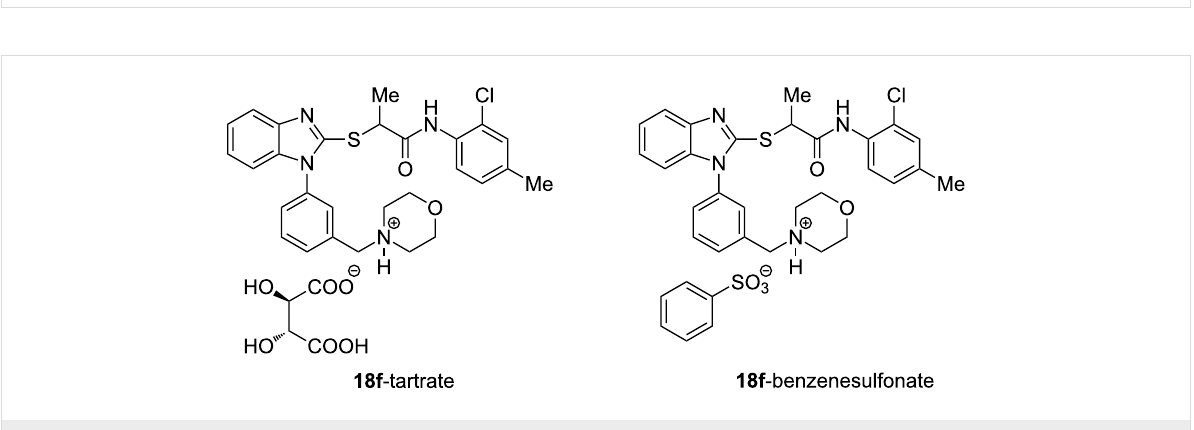
Figure 3: L-Tartaric acid salt ( 18f -tartrate) and benzenesulfonic acid salt ( 18f -benzenesulfonate) of 18f .